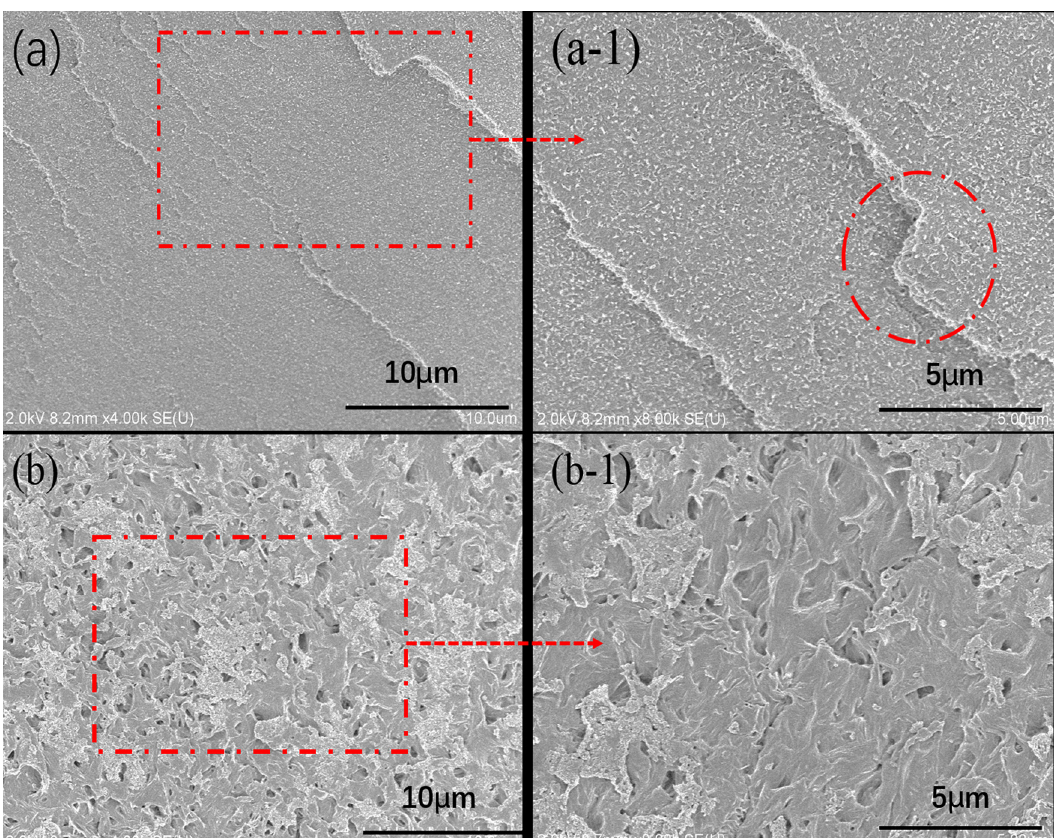
Figure 5: Cross - sectional SEM images of LDPE/PS interpolymer resin particles before and after etching PS component by THF: ( a ) before etching and ( b ) after